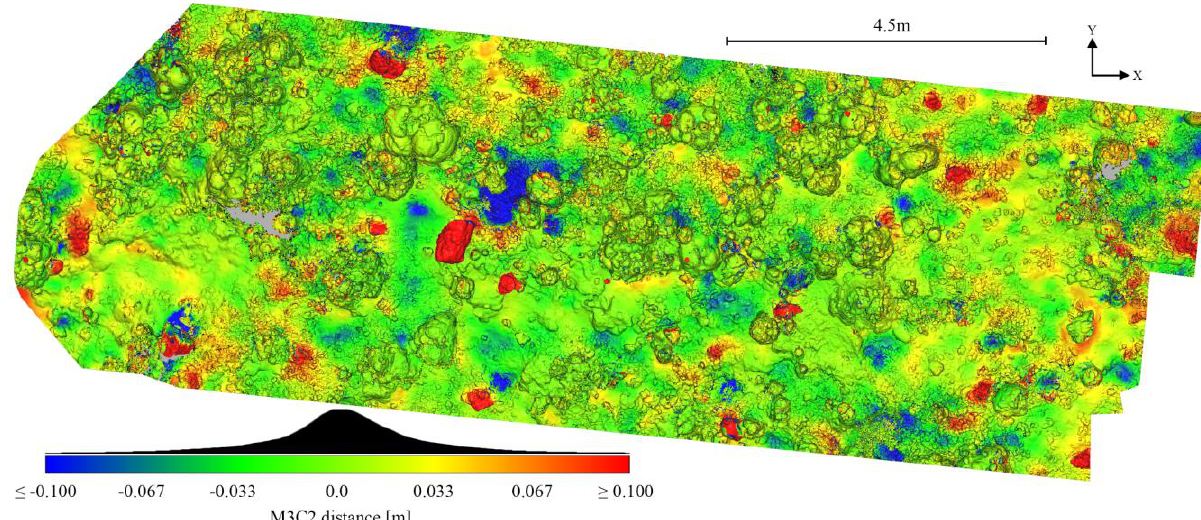
Fig.9: Colorized difference map after the ICP registration. In areas of obvious material ablation or accumulation, differences exceed 0.5m (see text for explanation). The distribution of the differences are indicated in the histogram on top of the color bar. The mean of the difference, its standard deviation, and mean absolute deviation (mad) are 𝑑̅ = 0.002𝑚, 𝑠𝑡𝑑 = 0.069𝑚, 𝑚𝑎𝑑 = 0.035𝑚